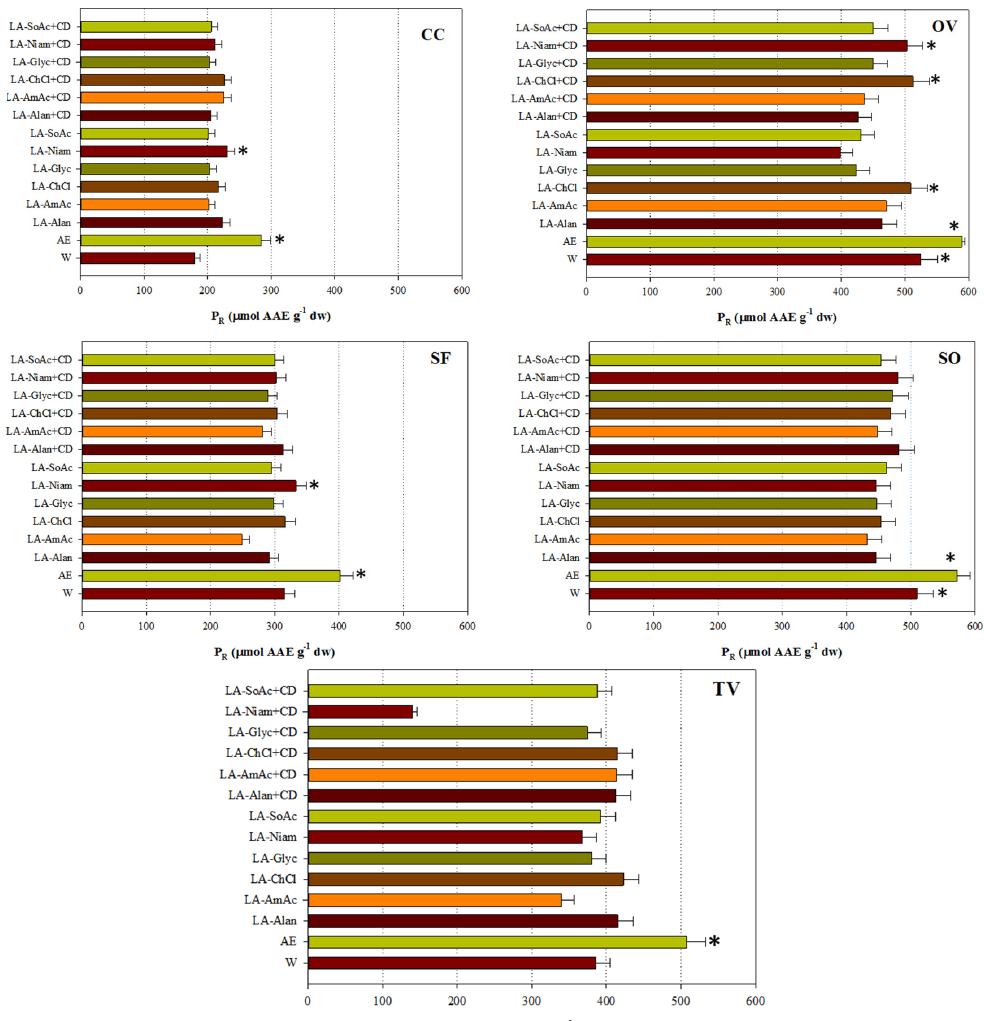
Figure 3. Plot showing the P R of the extracts obtained. Asterisk denotes statistically higher value ( p < 0.05). Assignments: CC, Coridothymus capitatus ; OV, Origanum vulgare ; SF, Salvia fruticosa ; SO, Salvia officinals ; TV, Thymus vulgaris .